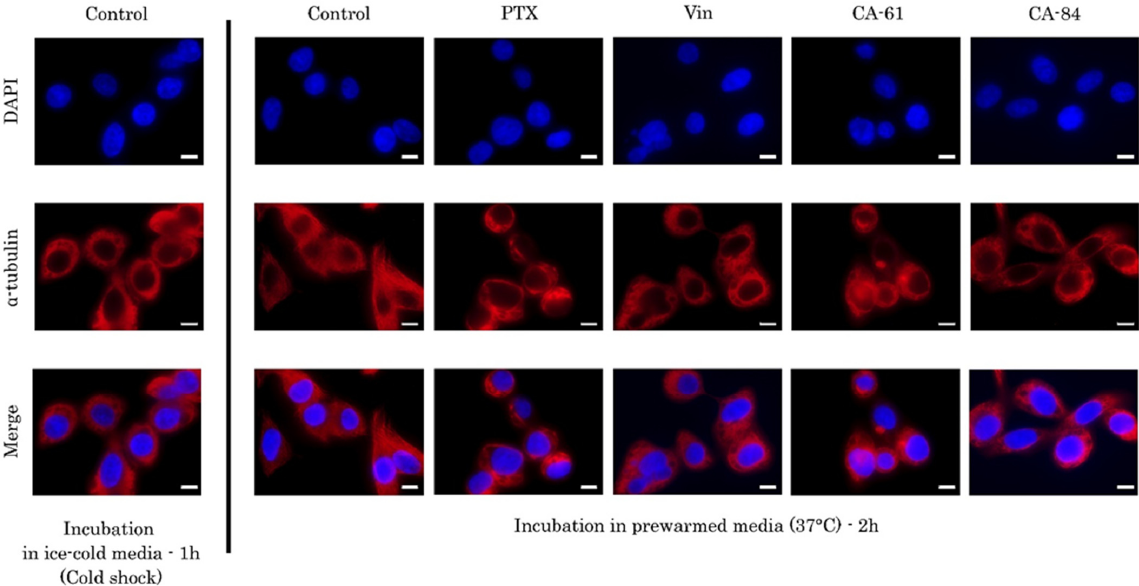
Figure 8. CAs inhibit the microtubules assembly in cold-shocked cancer cells. HCC1806 were incubated in ice-cold media (cold shock) within 1h in presence of DMSO (control), Paclitaxel (PTX—0.5 μ M), Vinblastine (Vin—0.01 μ M), CA-61 and -84 (10 μ M). After 1 h, the media were replaced with prewarmed media (37 °C) and cells were cultured for 2 h to initiate tubulin polymerization. Cells were fixed with a mixture of methanol and acetone, and stained with α -tubulin (red). DAPI nuclear staining (blue) was used to outline an equal number of cells. Images were captured by using a fluorescence Olympus BX63 microscope. Magnification 100×, scale bars 10 μ M.